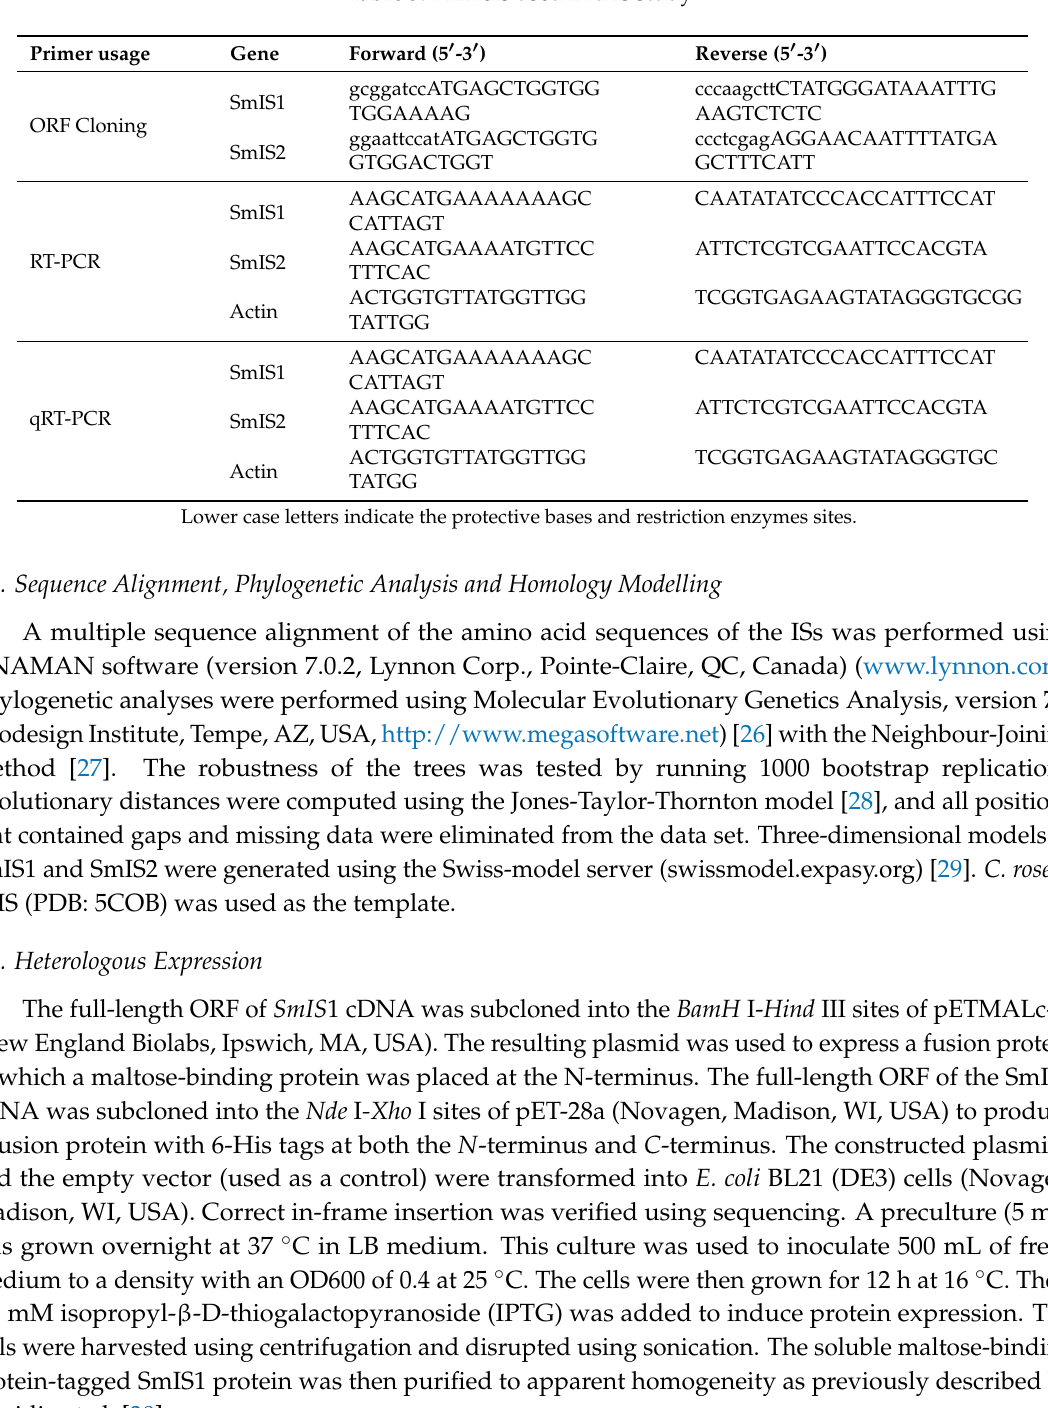
Table 3. Primers used in this